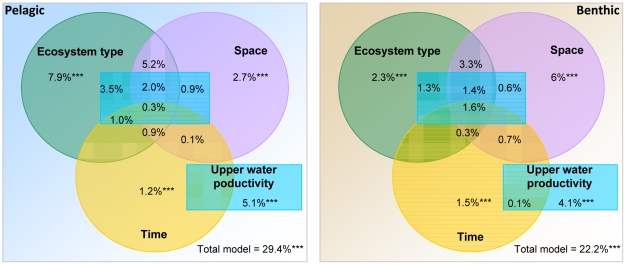
Global beta-diversity patterns of marine bacterial communities within each realm.The respective contributions of ecosystem type, geographic location (transformed latitudes and longitudes, water depth), time (number of days since the first sampling) and upper water productivity (as defined by Longhurst's primary production index and classes of capture fisheries yield) were assessed by using variation partitioning and are displayed as a Venn diagram. The blue boxes (i.e. upper water productivity) correspond to the fourth category of the model, which cannot be represented by a circle in such a display. The significance of each pure effect was validated by performing partial RDA with 1000 Monte Carlo permutation tests. Significance levels: *** P<0.001, **P<0.01, *P<0.05. Covariation parts cannot be tested for significance because they are numerically deduced from the pure parts [74].